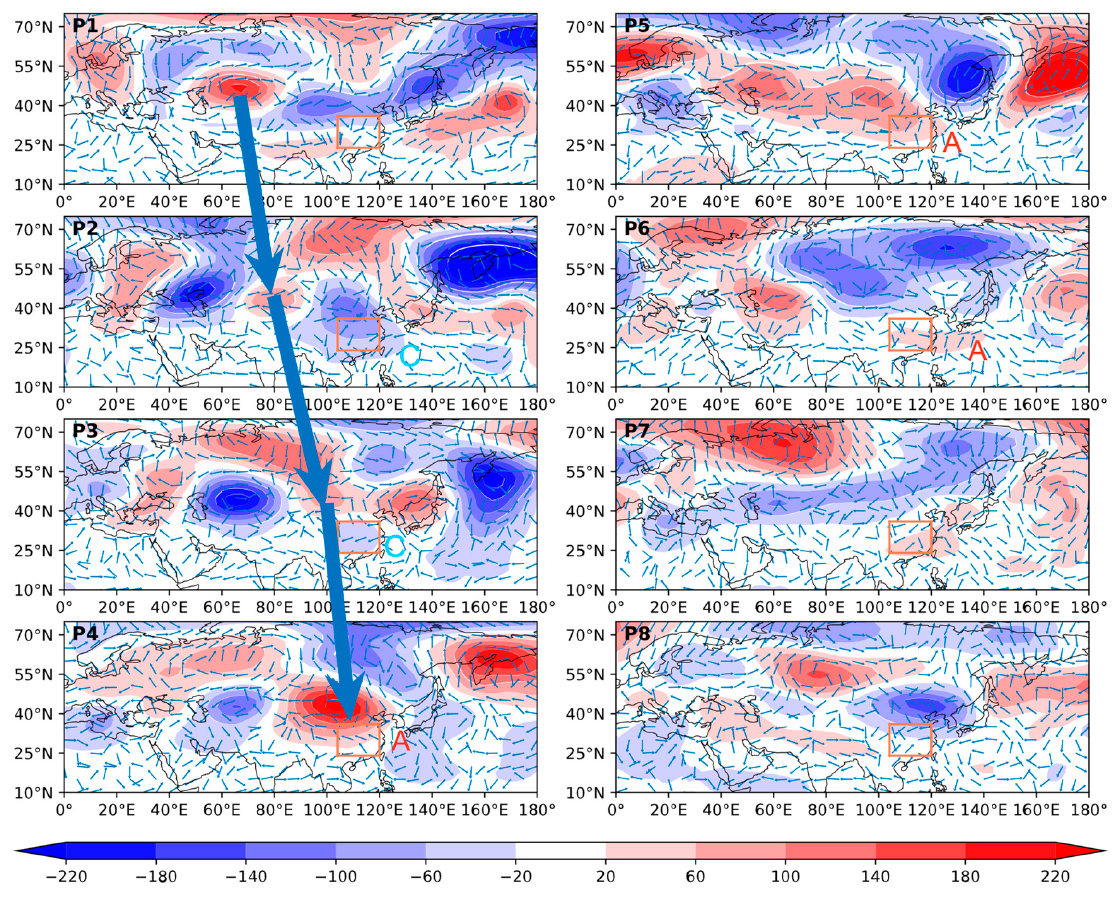
Figure 7. ISO component of geopotential height (shading; gpm) at 200 hPa and wind (vectors; 𝑚/𝑠 ) at 800 hPa in P1–8. A and C mark the anticyclonic and cyclonic wind anomalies at 800 hPa, respectively. The big blue arrow is to show the movement of the geopotential height anomaly influencing South China at 200 hPa. The red box marks South China.